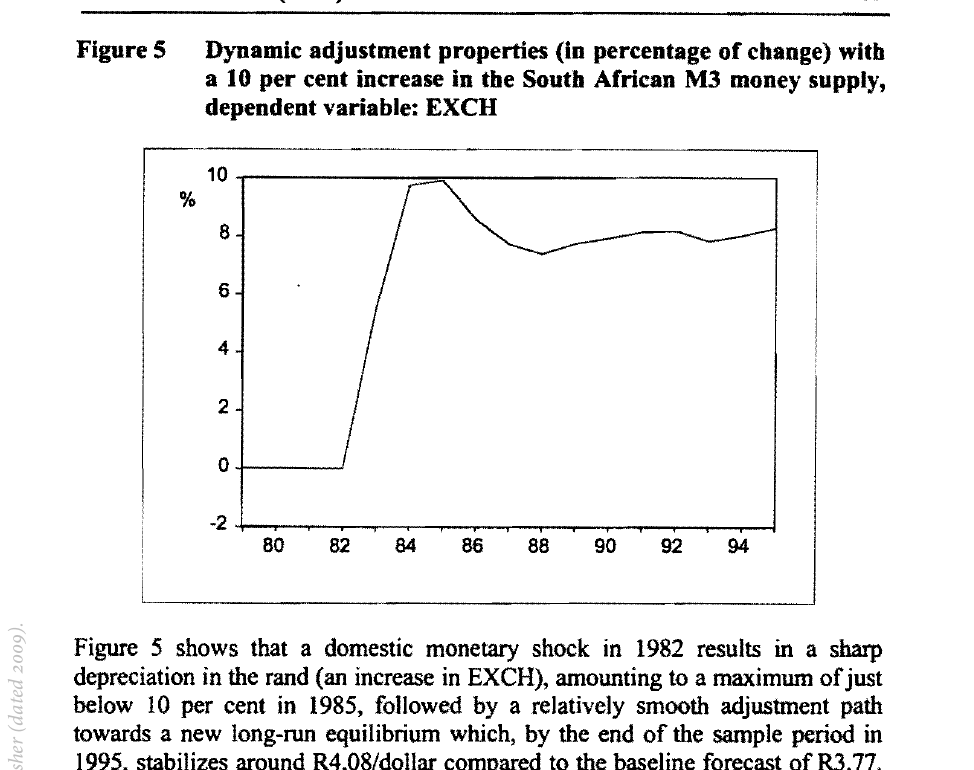
Dynamic adjustment properties (in percentage of change) with a 10 per cent increase in the South African M3 money supply, dependent variable: